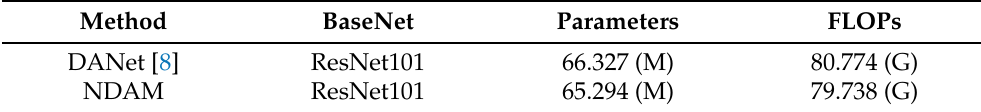
Table 2. To evaluate the model complexity of NDAM on the PASCAL VOC 2012 dataset, we use 1 × 3 × 513 × 513 feature maps as input.